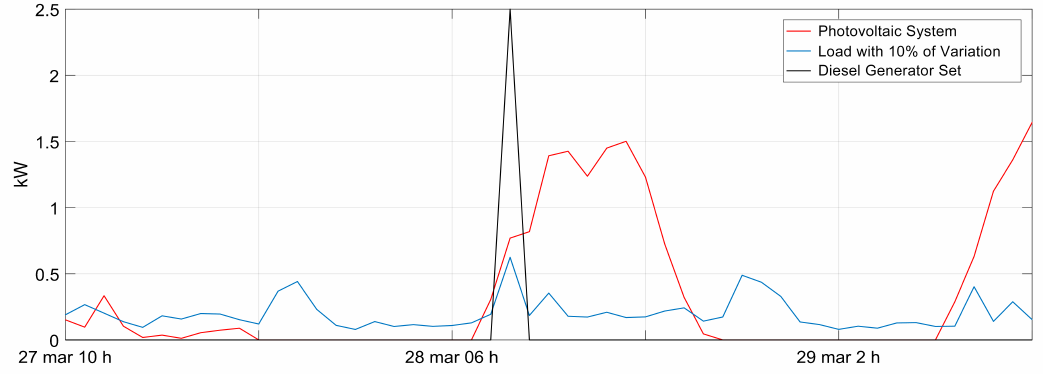
Figure 11. Behavior of the photovoltaic-diesel HES when there is low photovoltaic (PV) production with the activation of the diesel generator